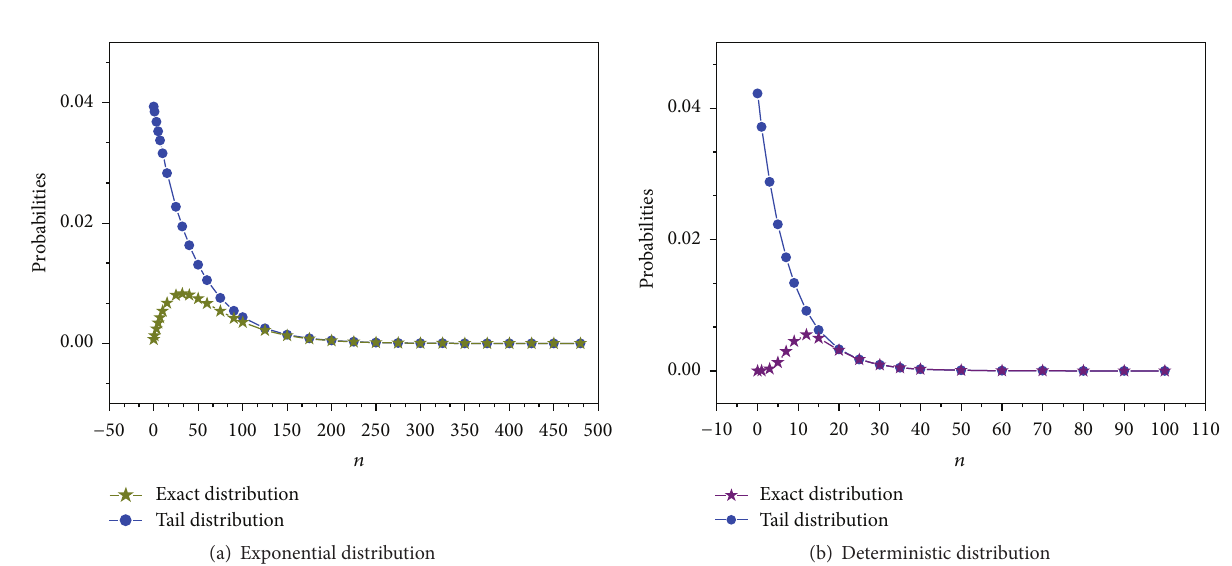
Figure 1: Exact and tail